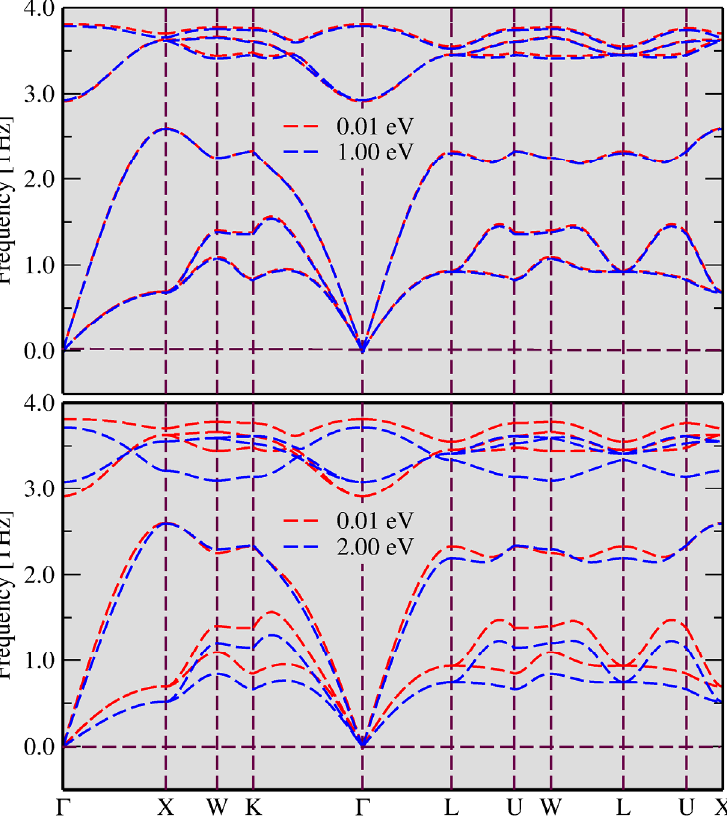
Figure 3. Phonon band structure for AgBr. The electronic temperature of T e = 0.01 eV (red) was compared with T e = 1.00 eV (blue, upper panel) and T e = 2.00 eV (blue, bottom panel).